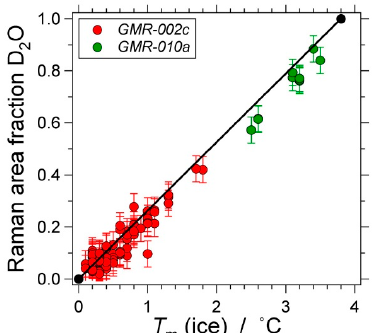
Figure 7. Comparison of the melting temperature of ice (H 2 O-D 2 O mixtures) in re-equilibrated fluid inclusion assemblages from the experiments GMR-002c and GMR-010a and area fractions in the corresponding Raman spectra. The diagonal solid line represents the ideal mixing of H 2 O and D 2 O.